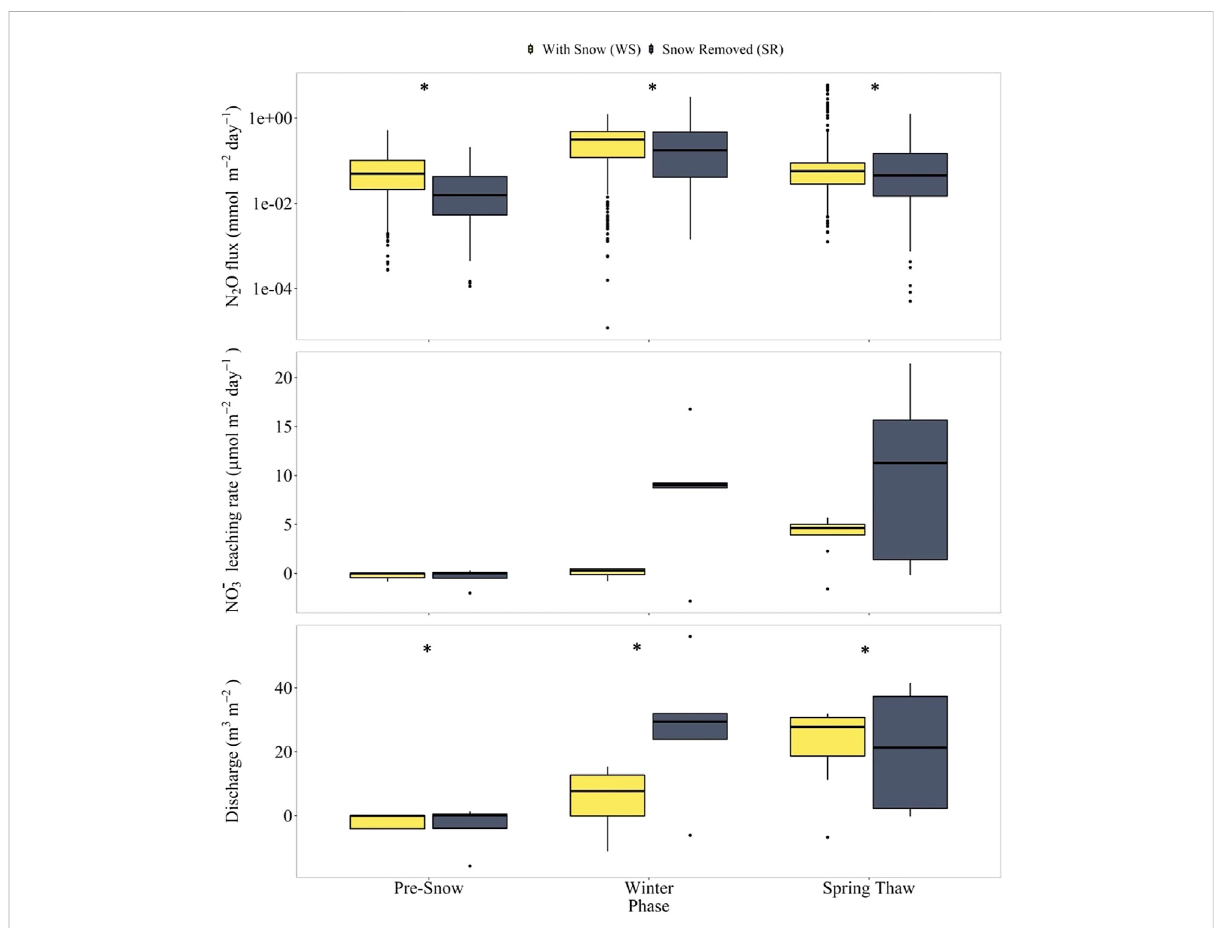
FIGURE 6 Box plots of N 2 O fl uxes (top panels), NO 3 − leaching rates (middle panels), and discharge rates (bottom panels) in loamy sand lysimeters LS-SR and LS-WS during the pre-snow, winter with/without snow, and spring-thaw phases. The y -axis for the N 2 O fl uxes is a log-axis (top panel only). An * above the boxplots signi fi es median valuesthat are statistically signi fi cant between theSR and WS lysimeters. Values are statistically signi fi cant when p ≤